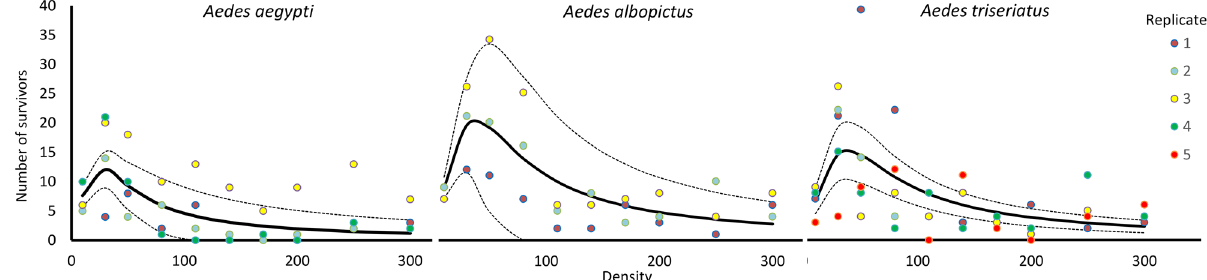
Figure 2. Survivorship to adulthood S versus initial density N for Aedes aegypti. Aedes albopictus, and Aedes triseriatus . The solid black line is the prediction for the regression of number of surviving adults vs. density (Eq. 2) removing effects of random variation among blocks, and the dotted lines indicate 95% maximum likelihood confidence interval on that prediction (SAS PROC NLMIXED), also removing the effects of random variation among blocks. Because S cannot be less than 0 the graph is truncated at 0 survivors; some lower confidence limit estimates reached values of ~ -1. Best fit parameters for A. aegypti, A. albopictus, and A. triseriatus are given in Table 3. The color of data points corresponds to the different replicate blocks for each species. Model: parameter affected by random replicate